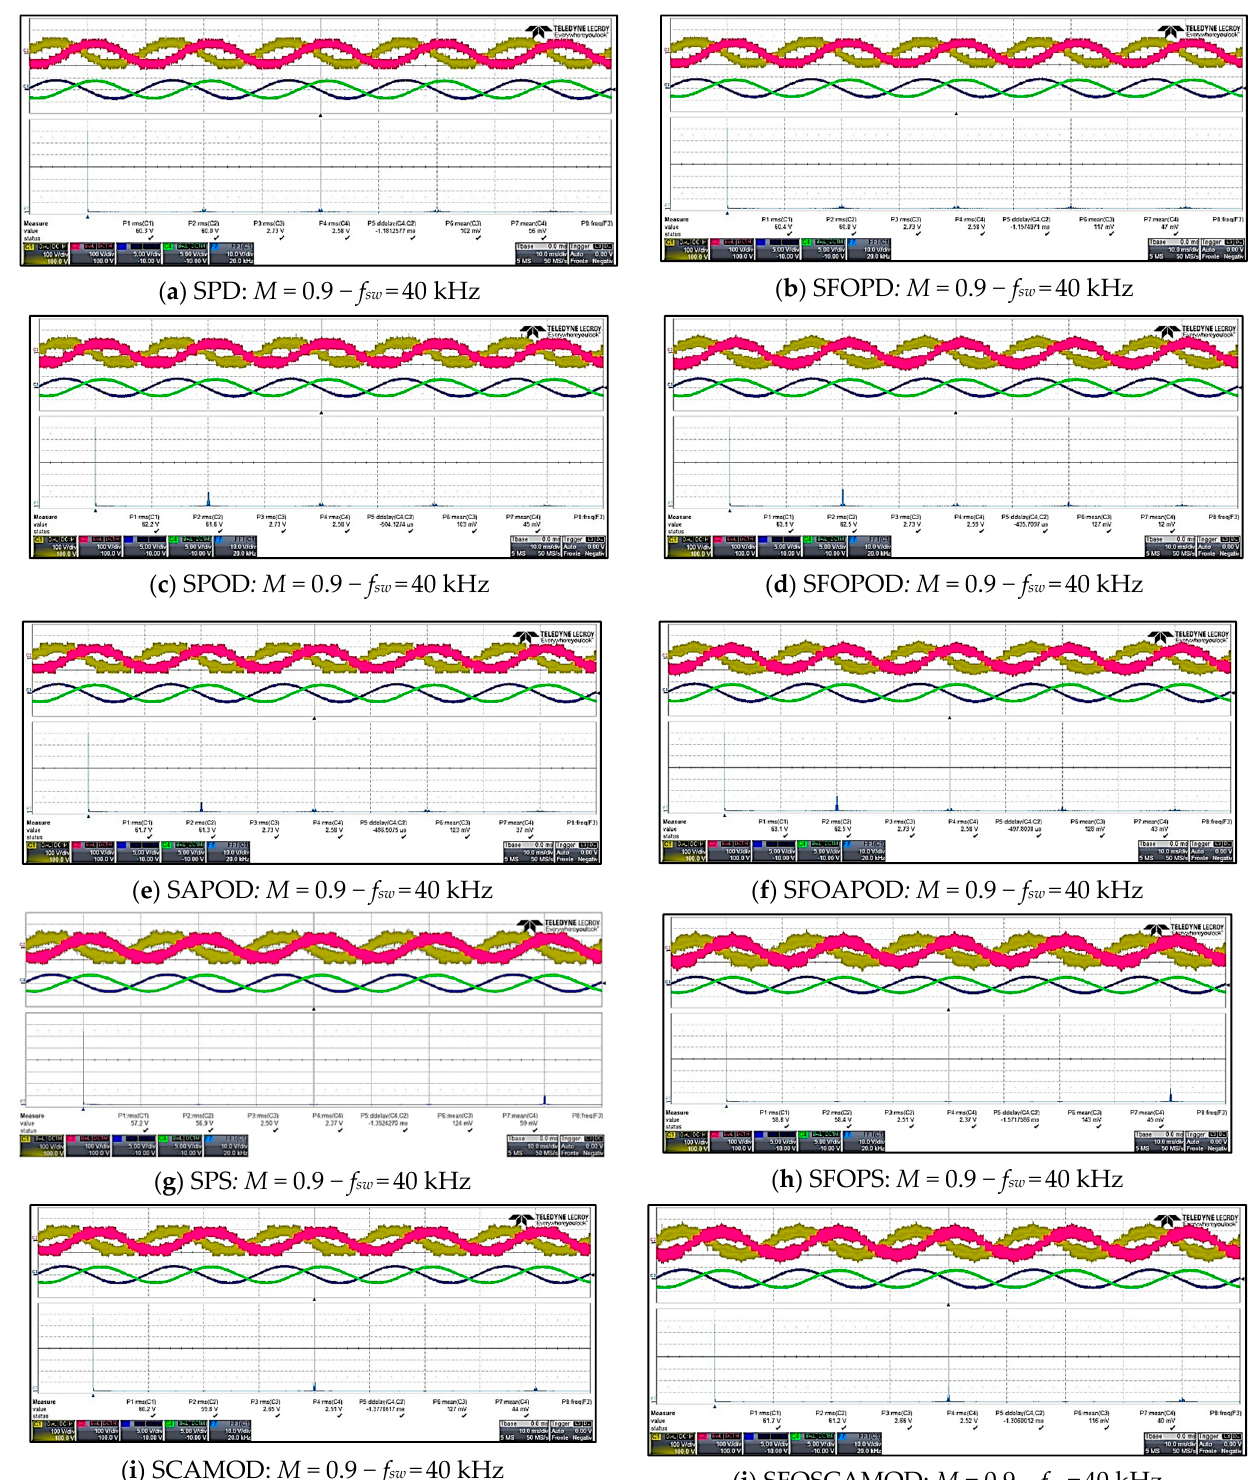
SCAMOD; ( j ) SFO SCAMOD.